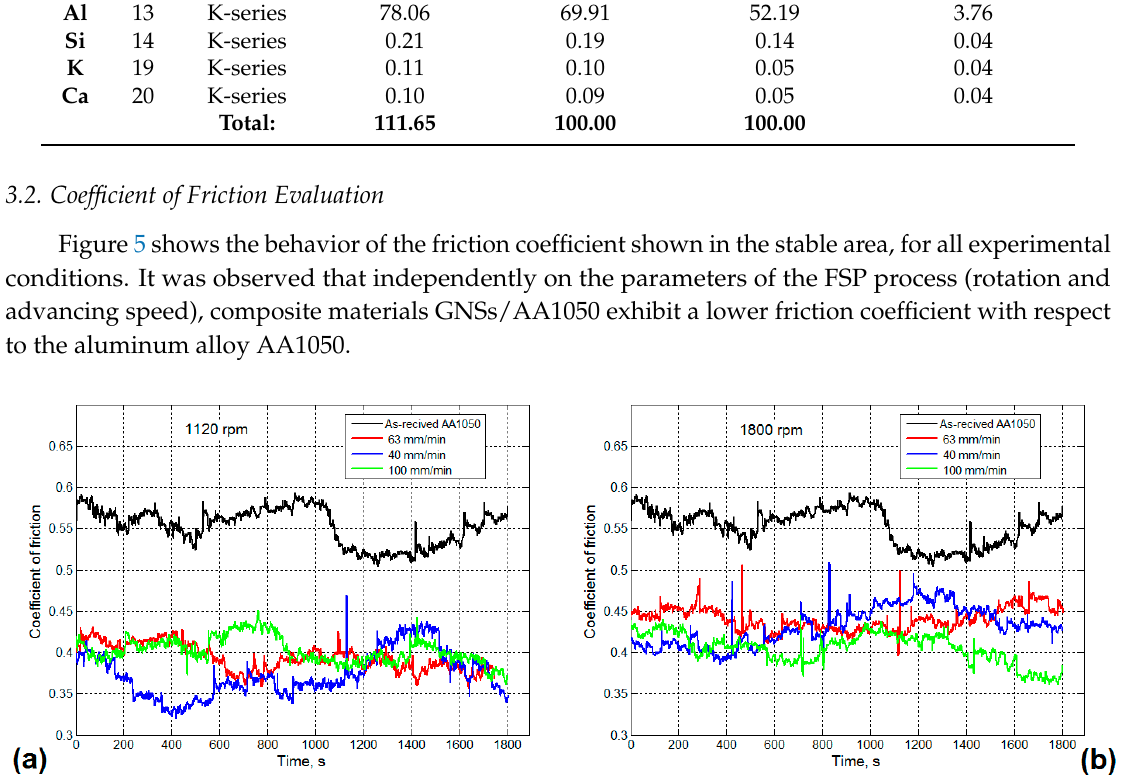
Figure 5. Friction coefficient of the composite material GNS/AA1050 obtained with three advancing speeds: ( a ) tool rotation speed 1120 rpm; ( b ) tool rotation speed 1800 rpm.